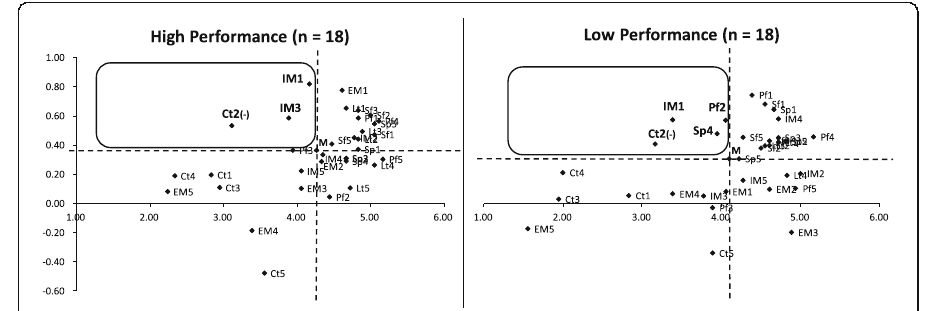
Fig. 3 Diagram of Mean of Correlation and Item Scores Based on Intention to Continue Shadowing